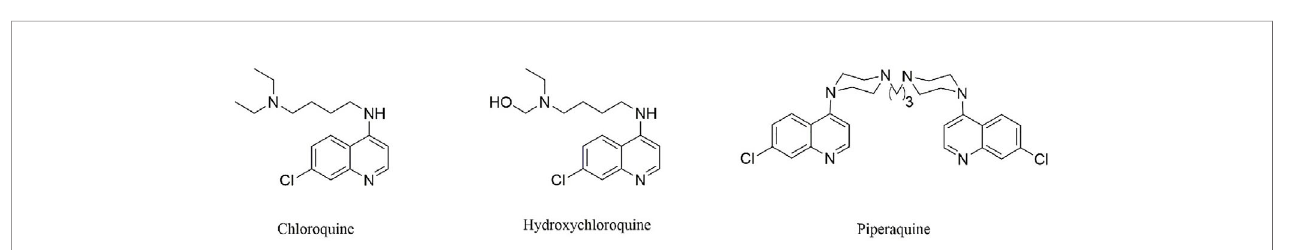
FIGURE 1 | The history of CQ and its analogs in clinical application.